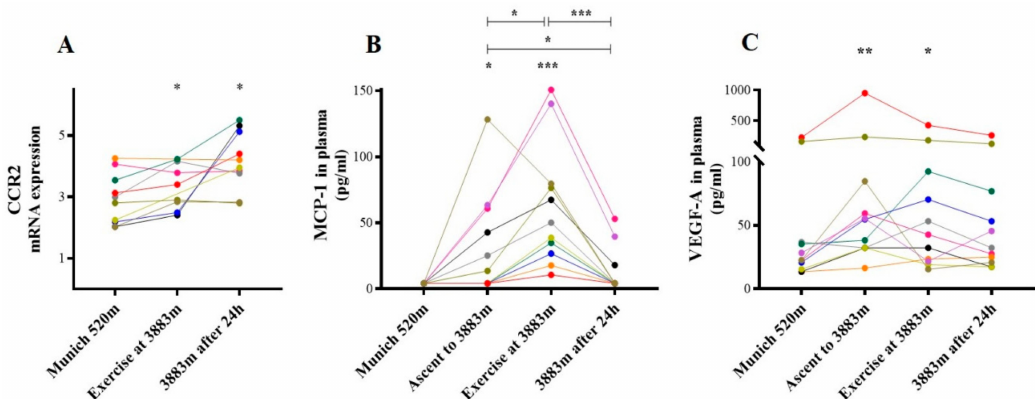
Figure 5. CCR-2, MCP-1, and VEGF-A in vivo. In vivo mRNA expression of ( A ) CCR-2 and ( B ) MCP-1, as well as ( C ) VEGF-A plasma concentration at time points analyzed; * p ≤ 0.05, ** p < 0.01, and *** p < 0.001 vs. baseline (Munich 520 m a.s.l.). CCR-2 = C-C chemokine receptor type 2. MCP-1 = Monocyte chemotactic protein 1. VEGF-A = Vascular epithelial growth factor